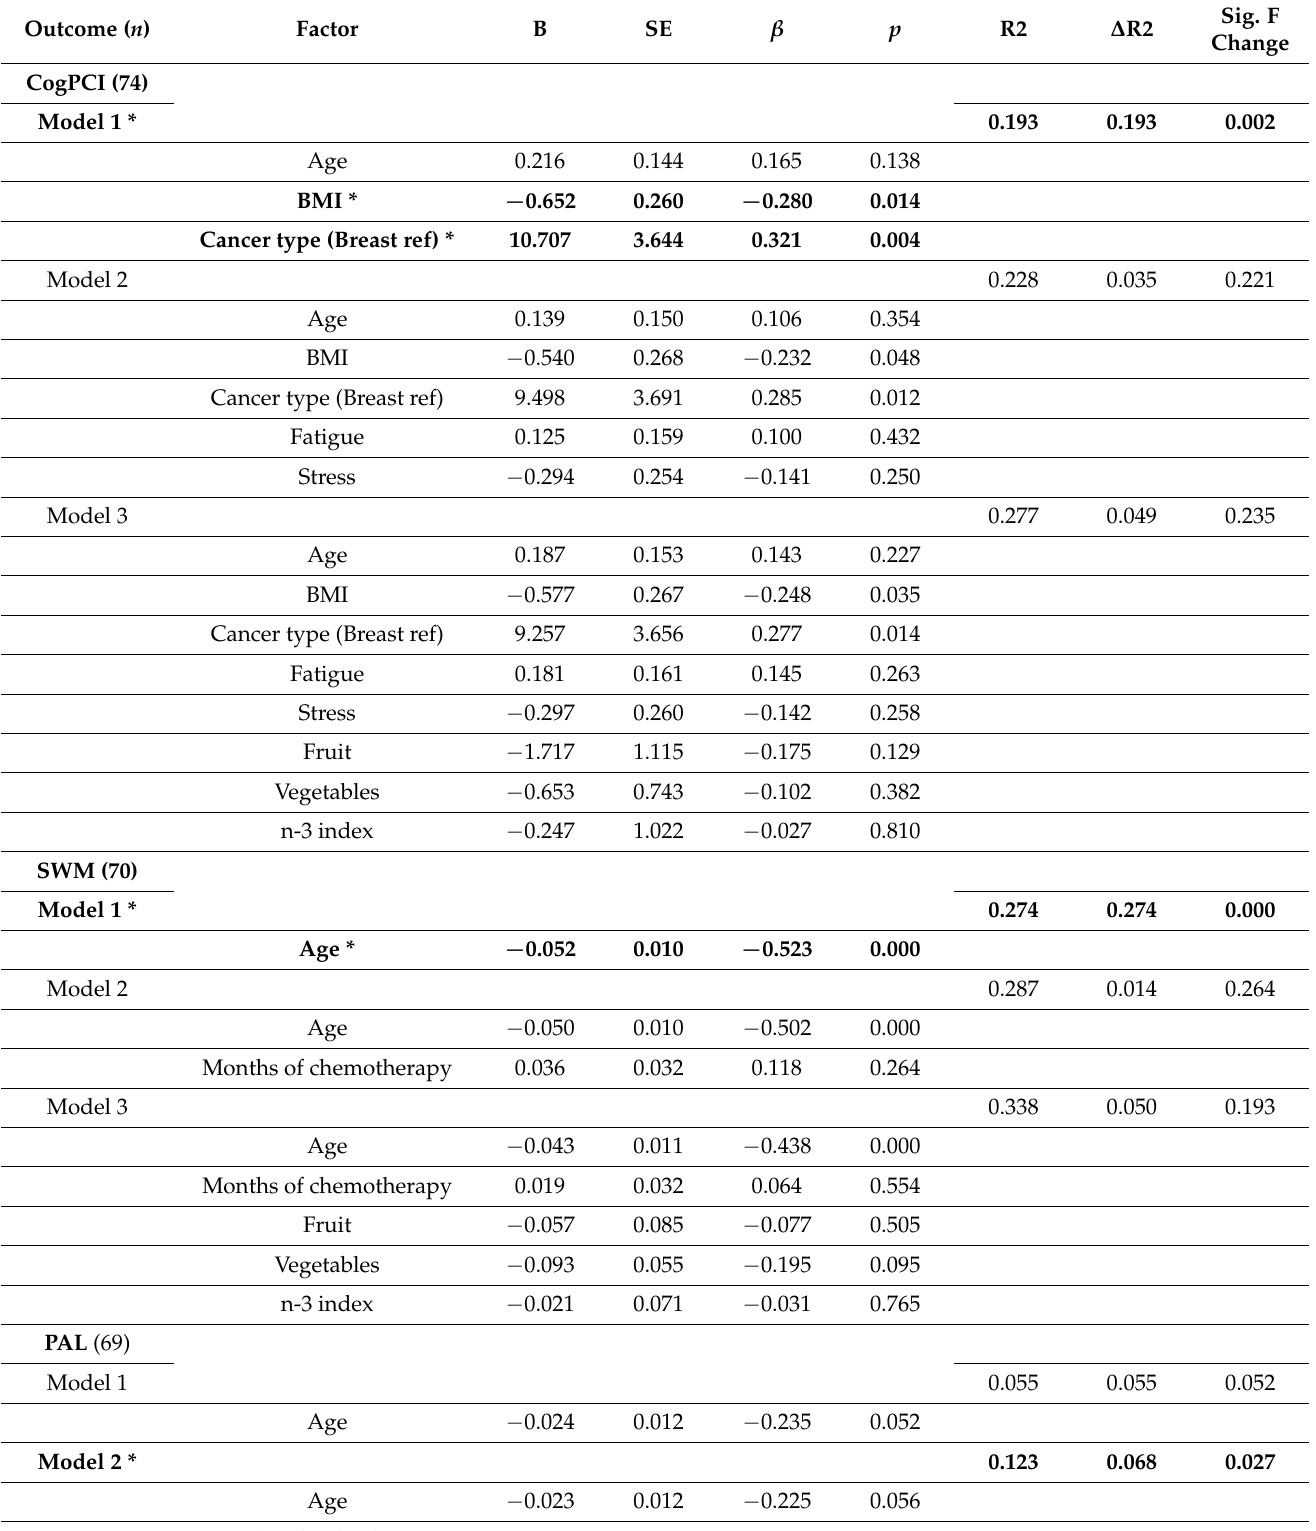
Table 4. Hierarchical linear regression models used to explore the dietary-cognitive